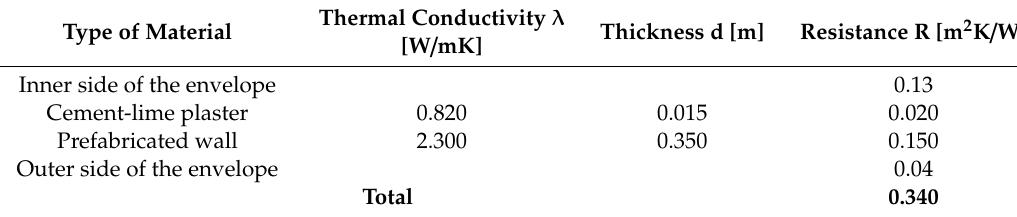
Table 2. Summary of thermal resistance for the longitudinal wall—the existing state.